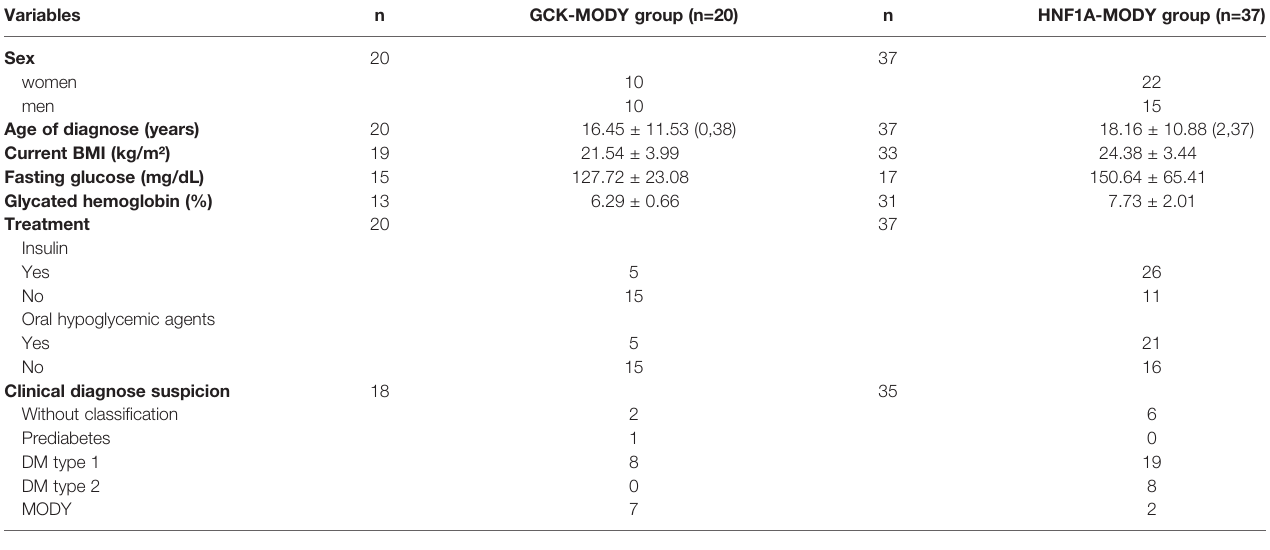
TABLE 1 | Clinical description of the sample